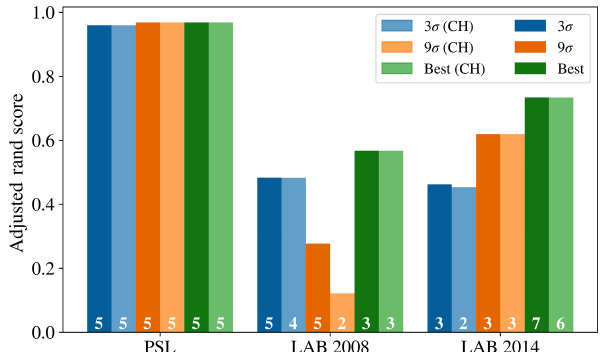
Figure 9. Performance of hierarchical agglomerative clustering us- ing the adjusted rand score for the data sets tested across differ- ent data preparation strategies. The number of clusters concluded in each case is indicated at the bottom of each